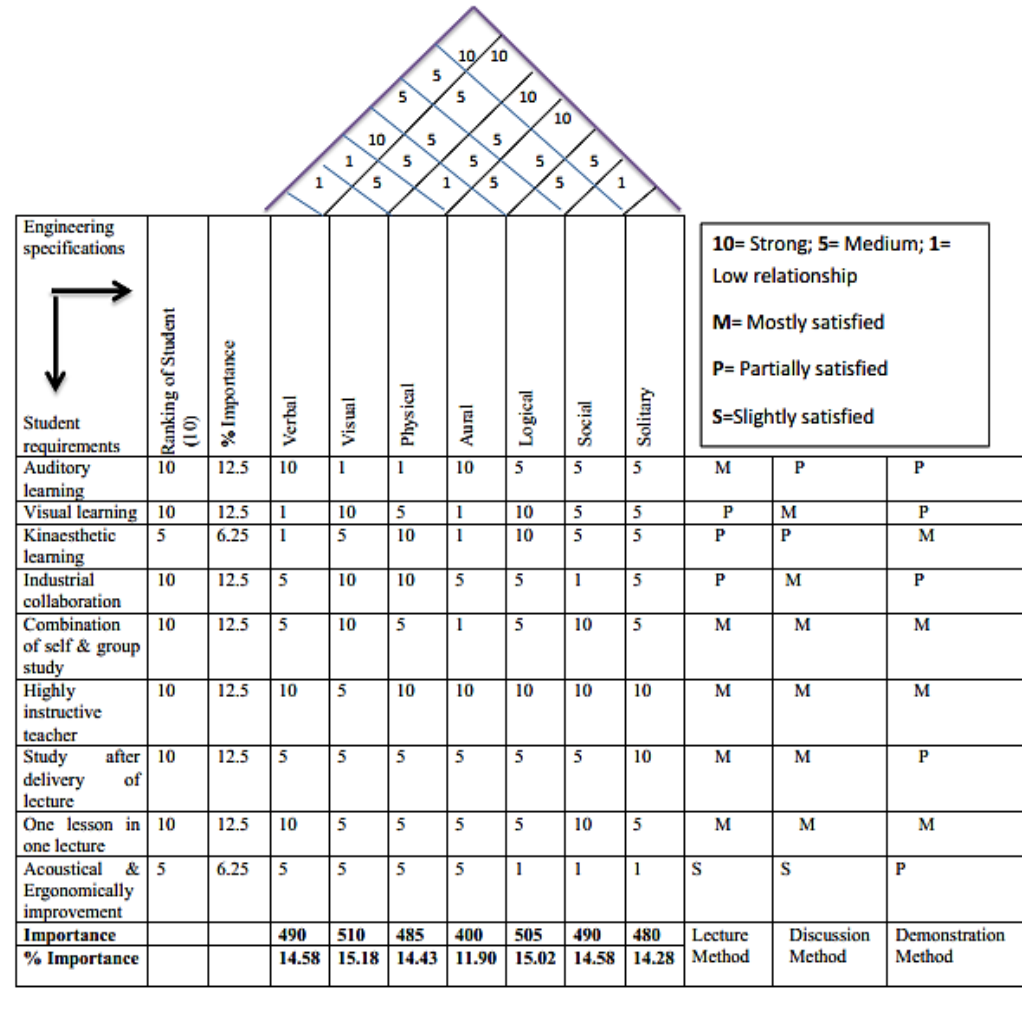
Figure. 1. Quality function